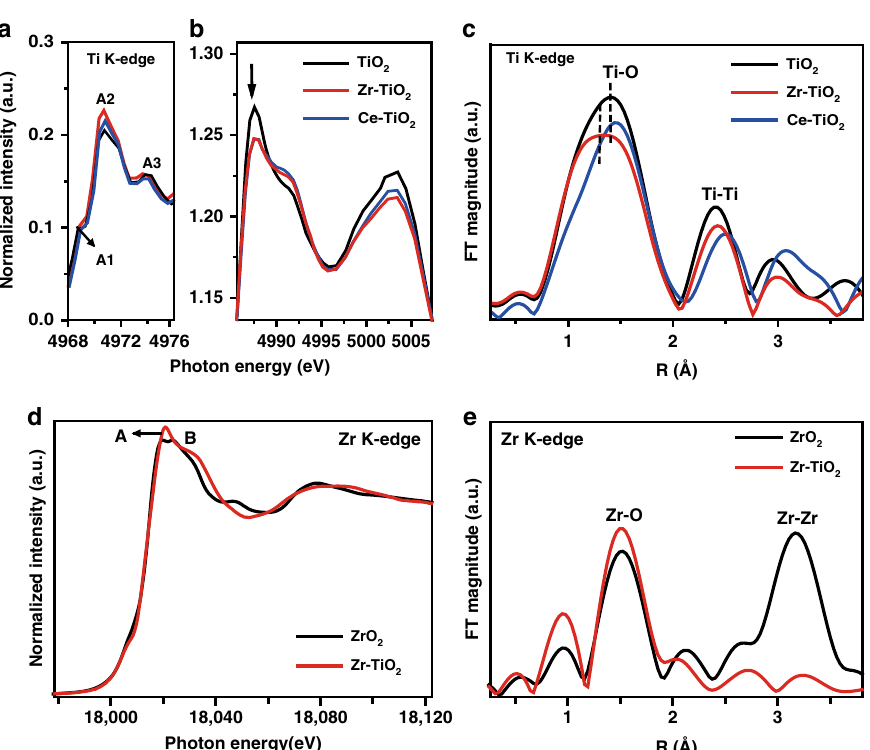
Fig. 6 X-ray absorption spectroscopy characterizations. a , b Enlarged Ti K -edge X-ray absorption near-edge structure (XANES) spectra, and c Fourier transformed (FT) k 3 -weighted of Ti K -edge Extended X-ray Absorption Fine Structure (EXAFS) spectra of the undoped TiO 2 , Zr-TiO 2 , and Ce-TiO 2 samples. d Zr K -edge XANES spectra and e Fourier-transformed k 3 -weighted of EXAFS spectra of pure ZrO 2 and Zr-TiO 2 samples. (Source data are provided as a Source Data fi